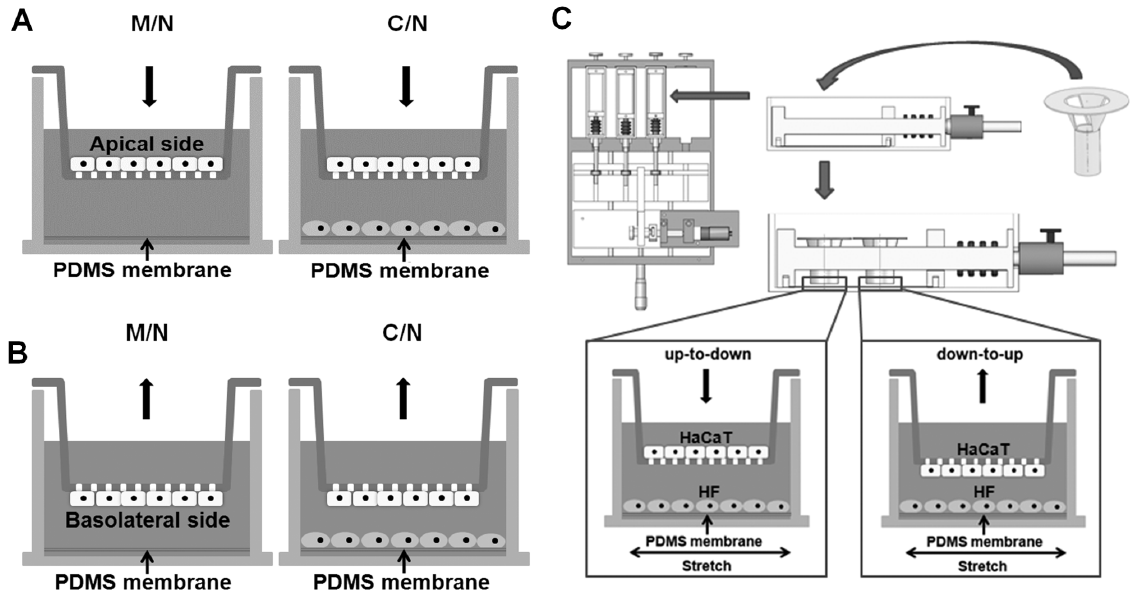
Figure 4. Transmembrane migration set-up of HaCaT or HF cells using a modified transwell assay. Plotted was up-to-down ( A ) or down- to-up ( B ) transmigration of monoclutured or cocultured HaCaT or HF cells in the absence or presence of mechanical stretch. Integration of the mechanical stretch assay with the modified transwell assay was also illustrated ( C ) and the detailed protocols were referred in Fig. S 4.